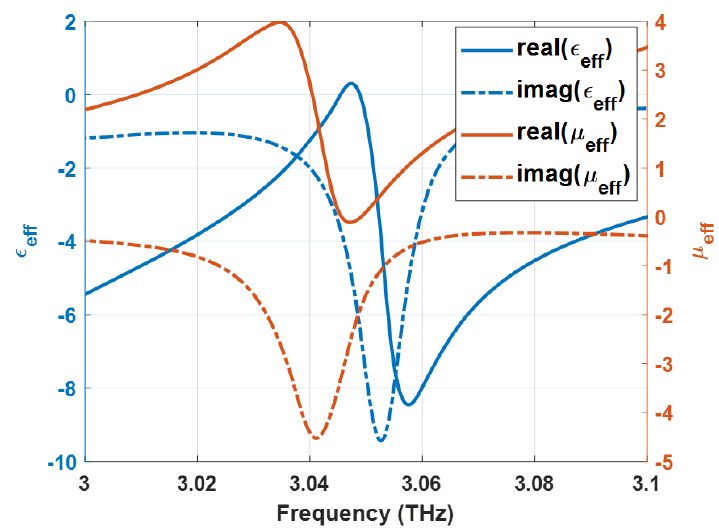
Figure 11. Effective permittivity and permeability at resonance frequency.